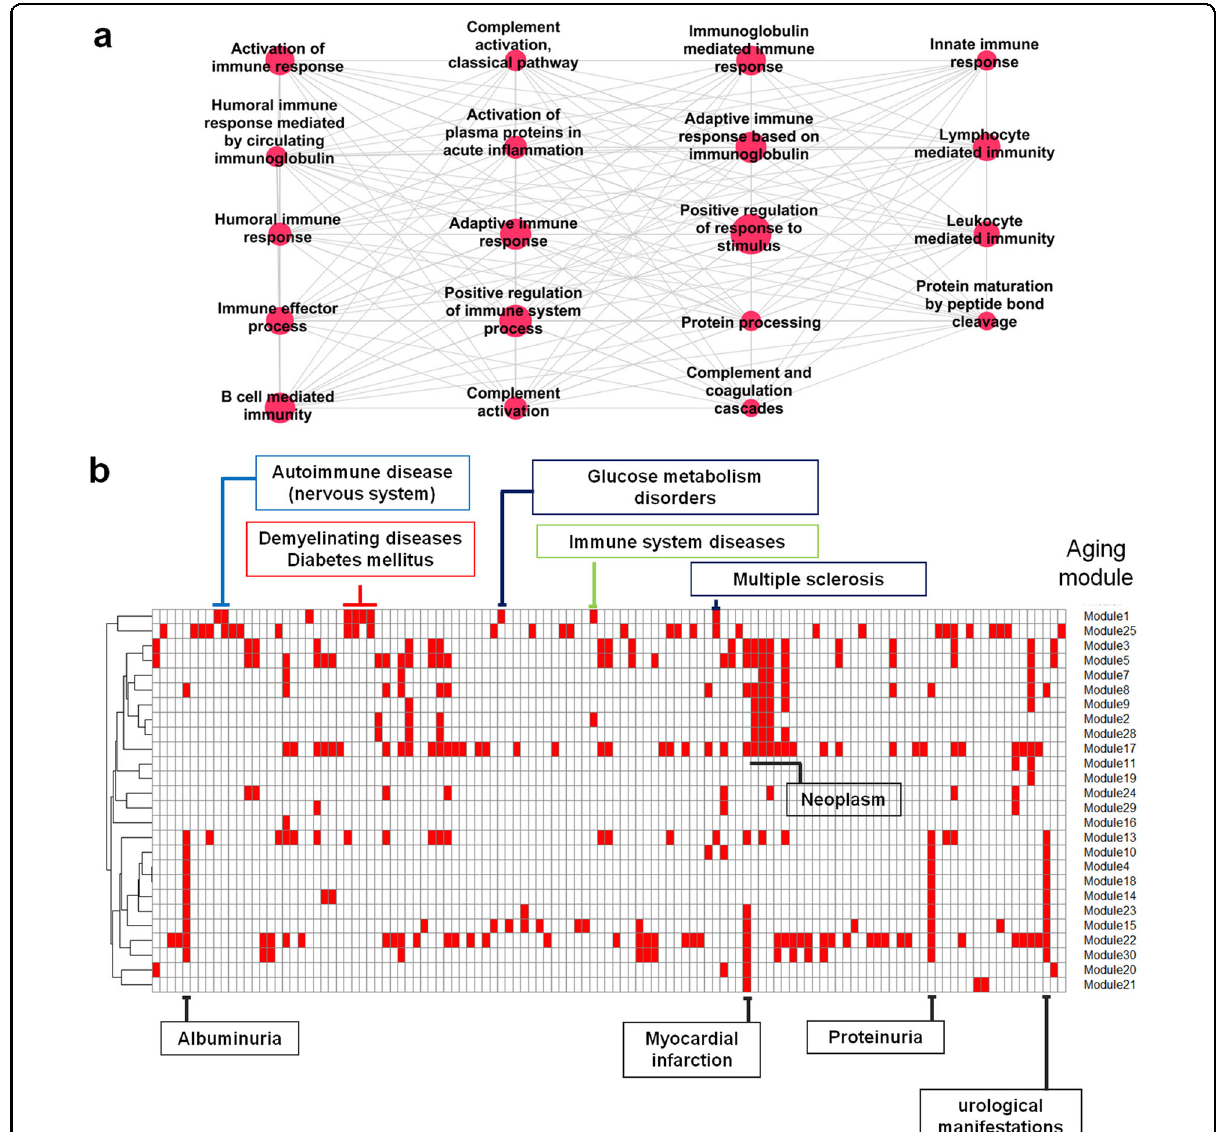
Fig. 2 Immune-related aging module and network separations between disease and aging modules. a Aging module 1 with the highest score of MCODE clustering algorithm 15 was implicated in immune processes. b Twenty-six aging modules topologically overlapped with several disease modules. Red rectangles indicate topological